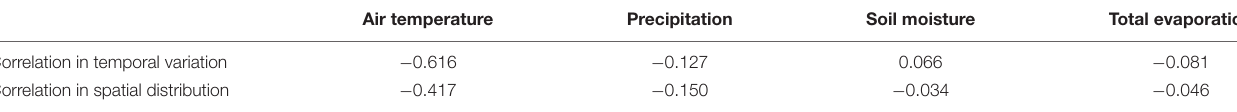
TABLE 1 | Correlation of interannual variation of the NDVI with air temperature, precipitation, soil moisture, and total evaporation.